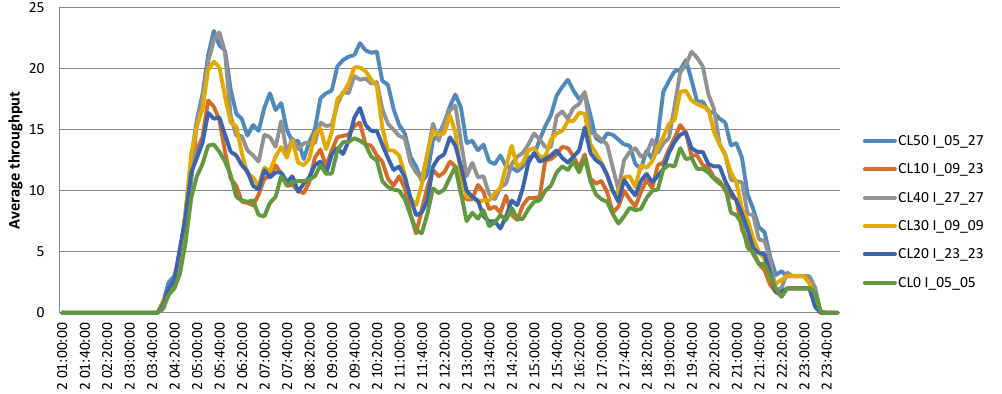
Figure 10. Comparison of saturation capacity throughput for each scenario .